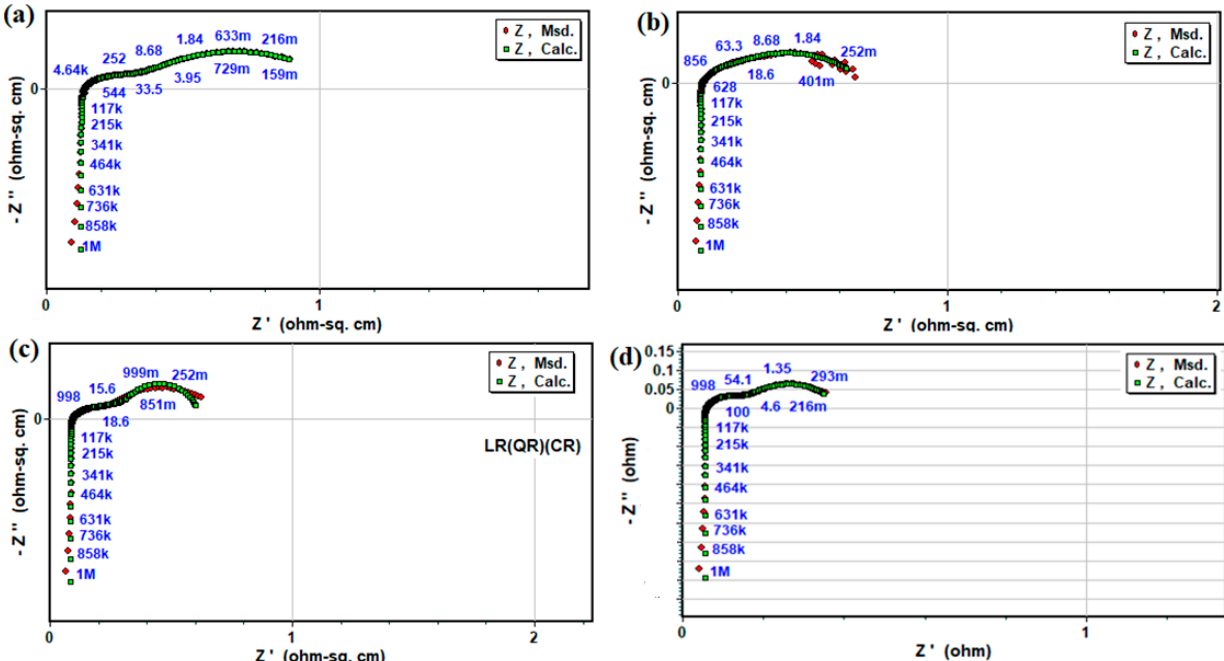
Figure 6. The electrochemical impedance spectroscopy measurements ( a ) using BCZYYb electrolyte, ( b ) SDC electrolyte, ( c ) 5SDC-5BCZYYb, and ( d ) 6SDC-4BCZYYb electrolyte fuel cell using NCAL electrode in H 2 /air operating at 550 °C, respectively.